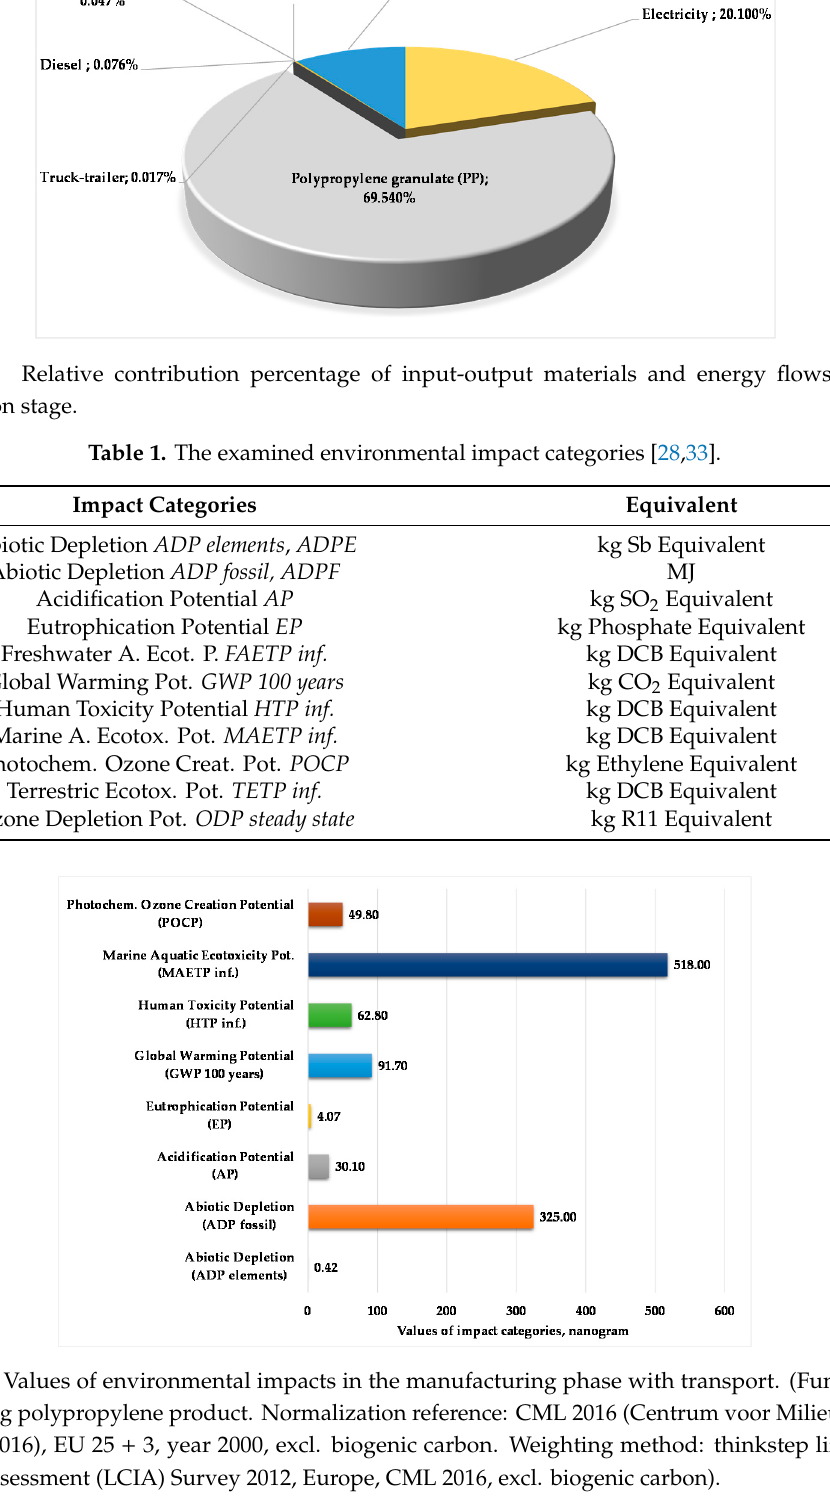
Figure 4. Values of environmental impacts in the manufacturing phase with transport. (Functional unit: 25 kg polypropylene product. Normalization reference: CML 2016 (Centrum voor Milieukunde